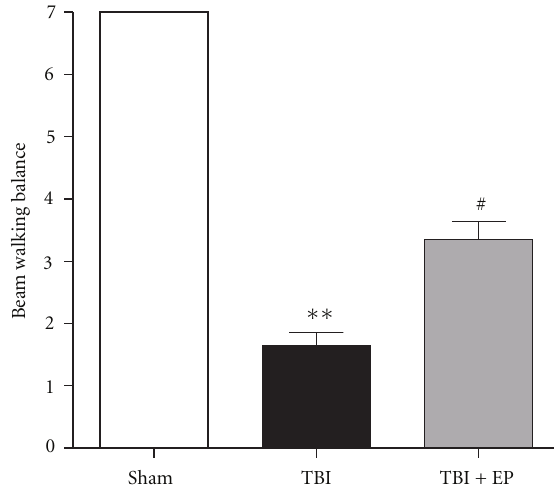
Figure 2: E ff ects of EP administration on functional outcomes in contusion injured rats as evaluated by beam walking balance tasks. Compared to rats in TBI group, EP administration attenuated the injury induced impairment in beam walking balance performance tested at 24 hours after TBI. Bars represent as mean ± SEM; n = 15, each group; ∗∗ P < . 01 versus Sham group, # P < . 05 versus TBI